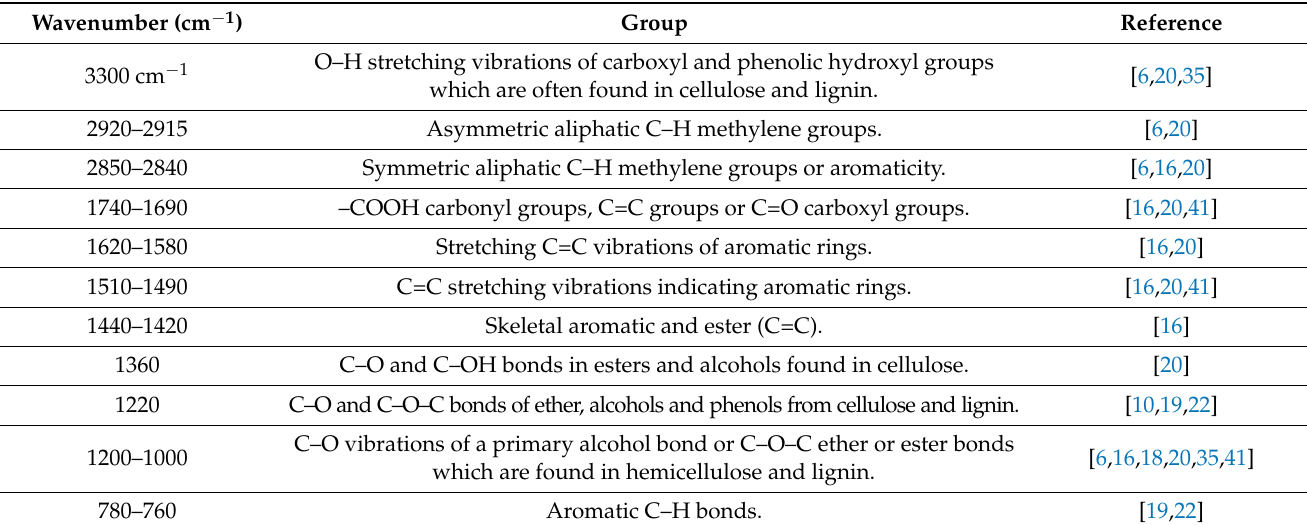
Table A3. FTIR major peaks and groups.